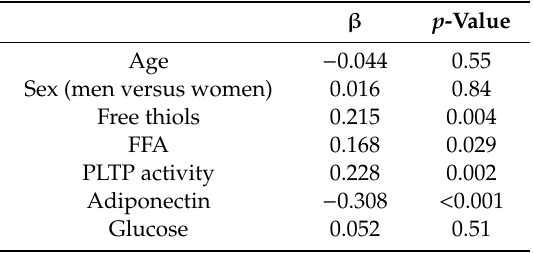
Table 4. Multivariable linear regression analysis demonstrating independent associations of plasma triglycerides with age, sex, free thiols, free fatty acids, phospholipid transfer protein activity